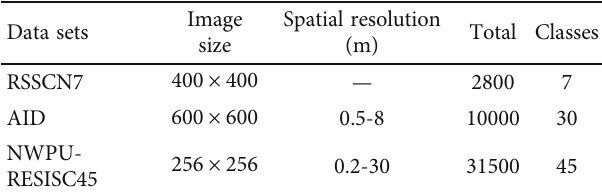
Figure 4: Some samples of key region localization in the RSSCN7 data set. The images from top to bottom are the following: original image, aggregation map, location results based on SCDA, and single-object region growth separately. Table 1: Comparison of di ff erent data sets.